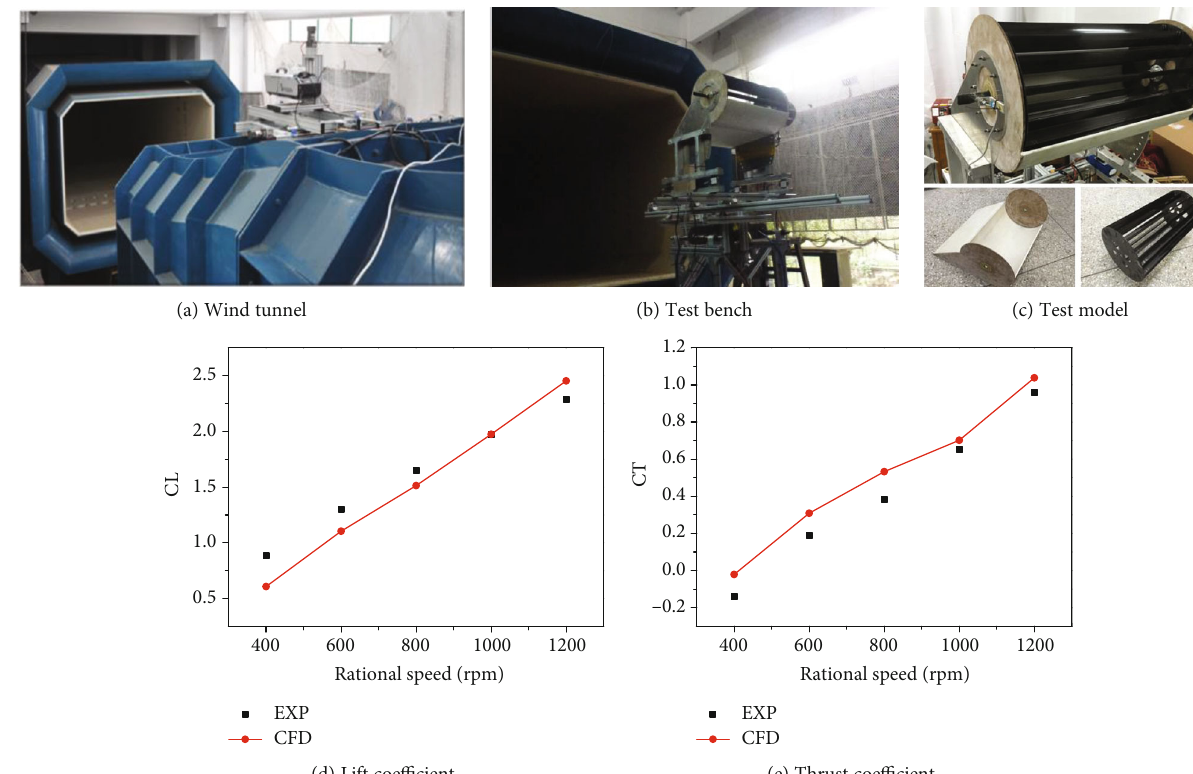
Figure 5: Comparisons between numerical calculation and experimental